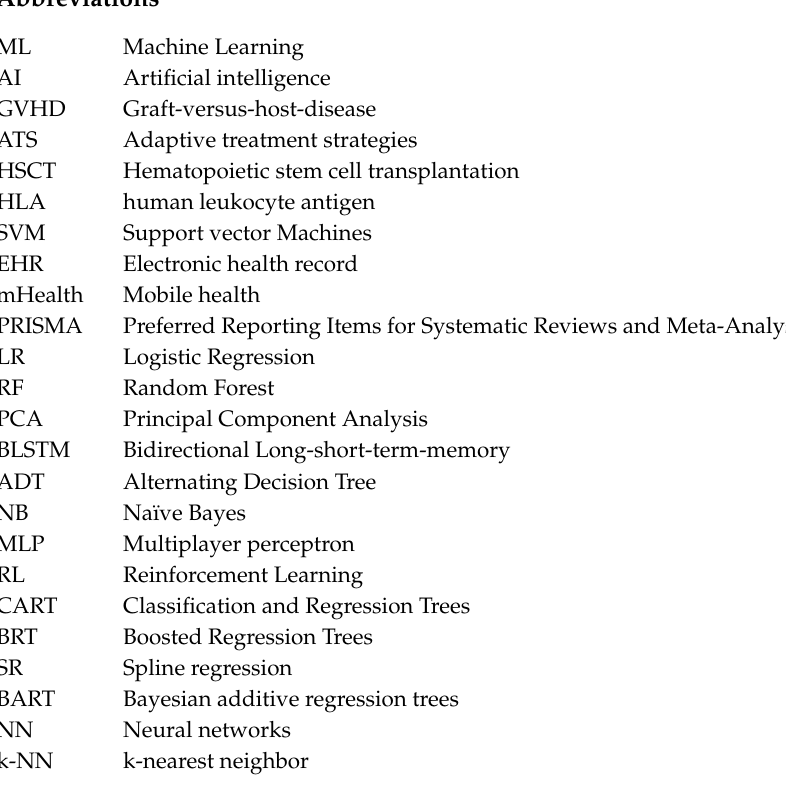
Table S1: Machine Learning Terms; Table S2: Distribution of studies for each broad ML category; Figure S1: Classification of ML Techniques used in Hematopoietic Stem Cell Transplantation (HSCT) reviewed studies; Figure S2: Distribution of studies by ML broad